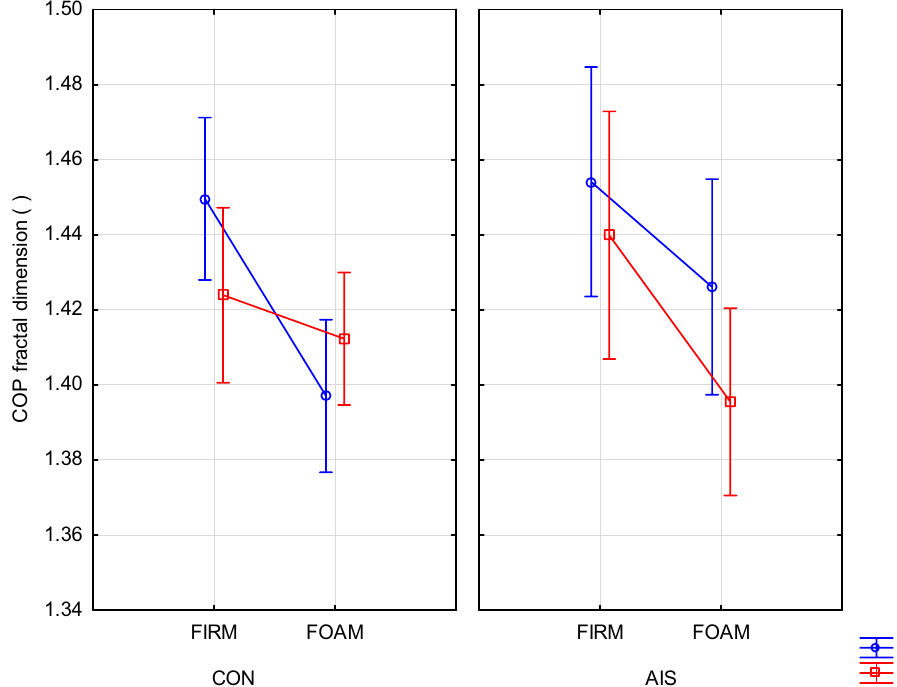
Figure 4. Group × Surface × Plane interaction (p = 0.00079) on COP fractal dimension for girls with scoliosis (AIS) and controls (CON) in trials with eyes open on firm or foam surface in the medial–lateral (ML) and antero-posterior (AP) plane.